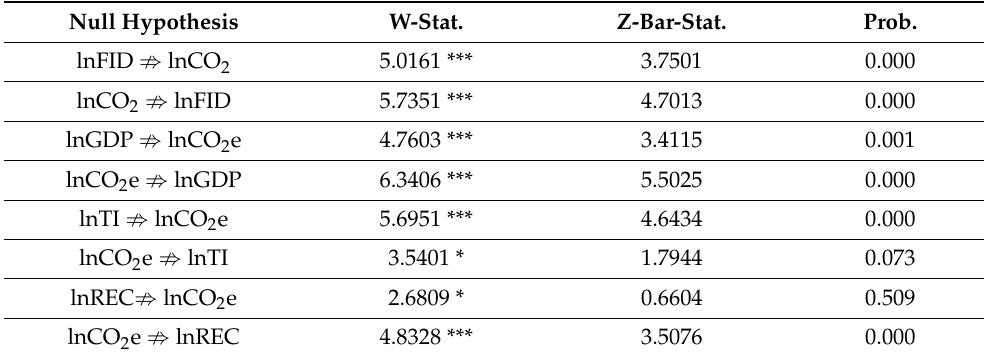
Table 9. Pairwise Dumitrescu & Hurlin, (2012) panel causality test